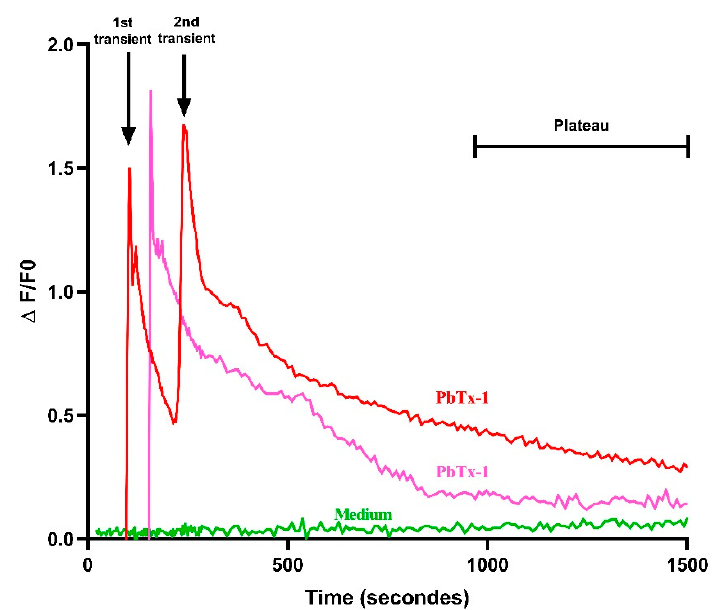
Figure 1. Representative profiles of PbTx-1-induced [Ca 2 + ] i increase in DRG sensory neurons highlighting different subpopulations of sensory neurons. Profiles in red and pink represent PbTx-1-induced [Ca 2 + ] i increase comprising of three phases (first transient, second transient and plateau) and two phases (transient and plateau), respectively. Medium (control) did not induce [Ca 2 + ] i increase as represented in the green line. [Ca 2 + ] i : intracellular calcium concentration; PbTx-1: brevetoxin-1.